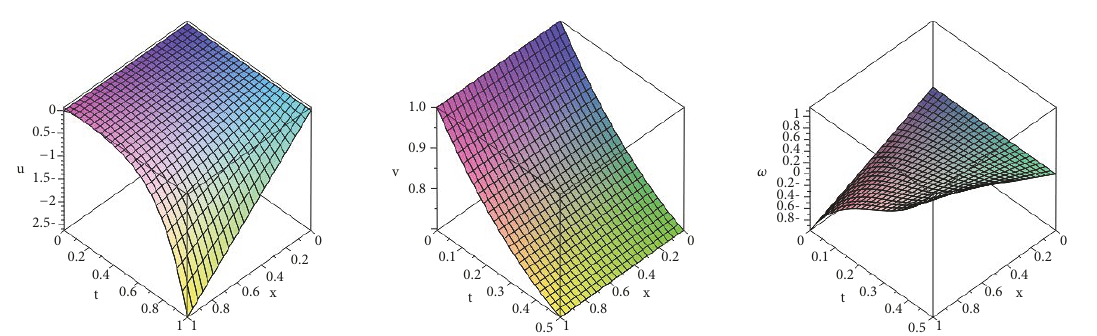
Figure 18: Surface of 𝑢 , V , and 𝜔 for 𝑀 = 2 , 𝑆 = −10 , 𝛾 = 0.3 , 𝑦 = 1 , 𝛼 = −2 , l = 1 .